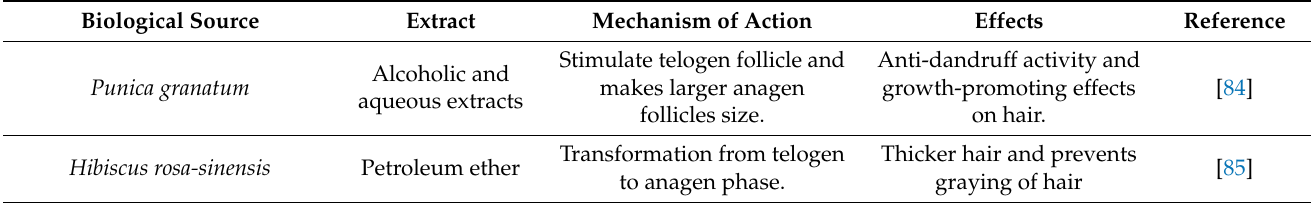
Table 4. Herbal medicines act by modulating the hair